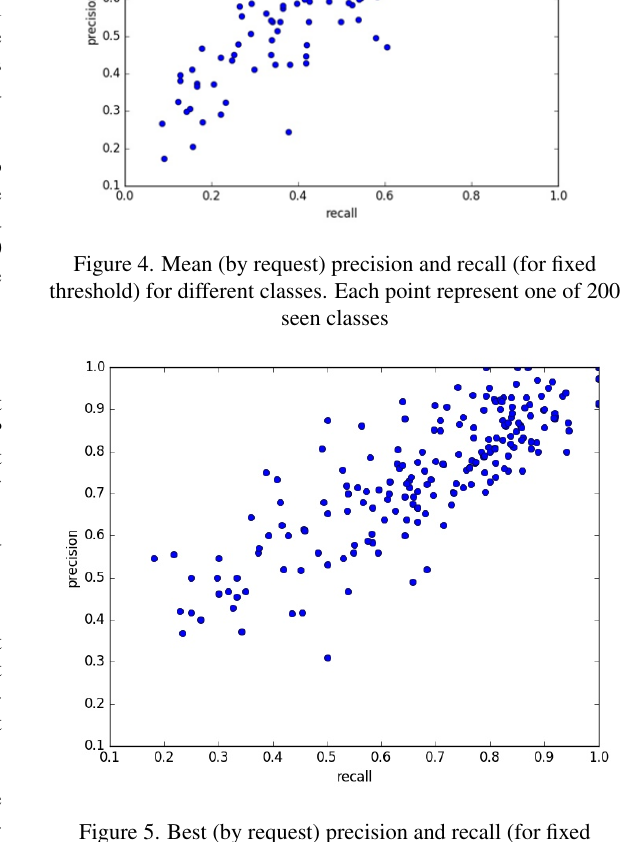
Figure 5. Best (by request) precision and recall (for fixed threshold) for different classes. Each point represent one of 200 seen